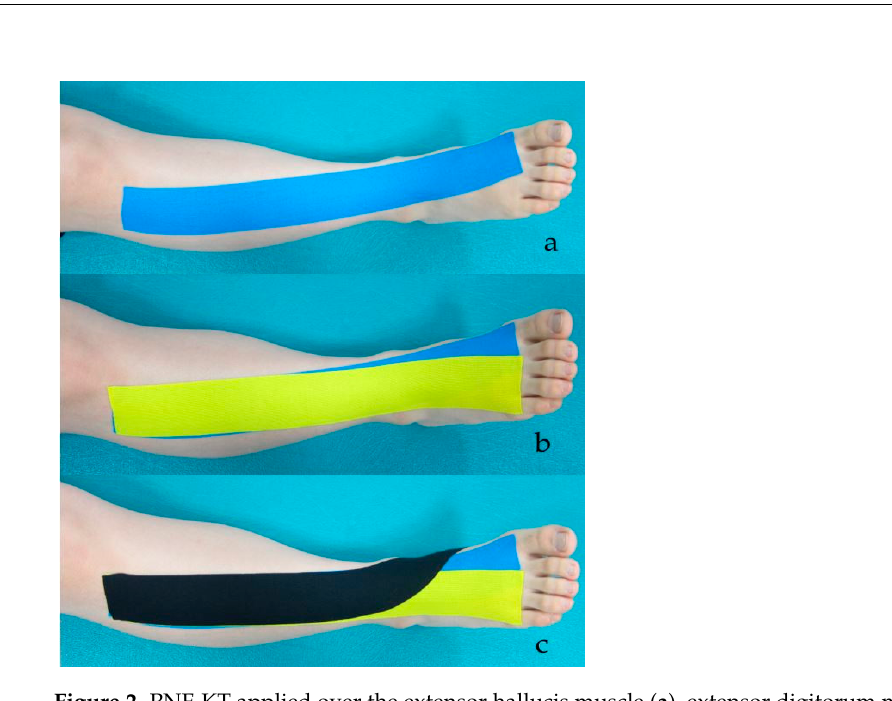
Figure 2. PNF-KT applied over the extensor hallucis muscle ( a ), extensor digitorum muscle ( b ), and tibialis anterior muscle ( c ).